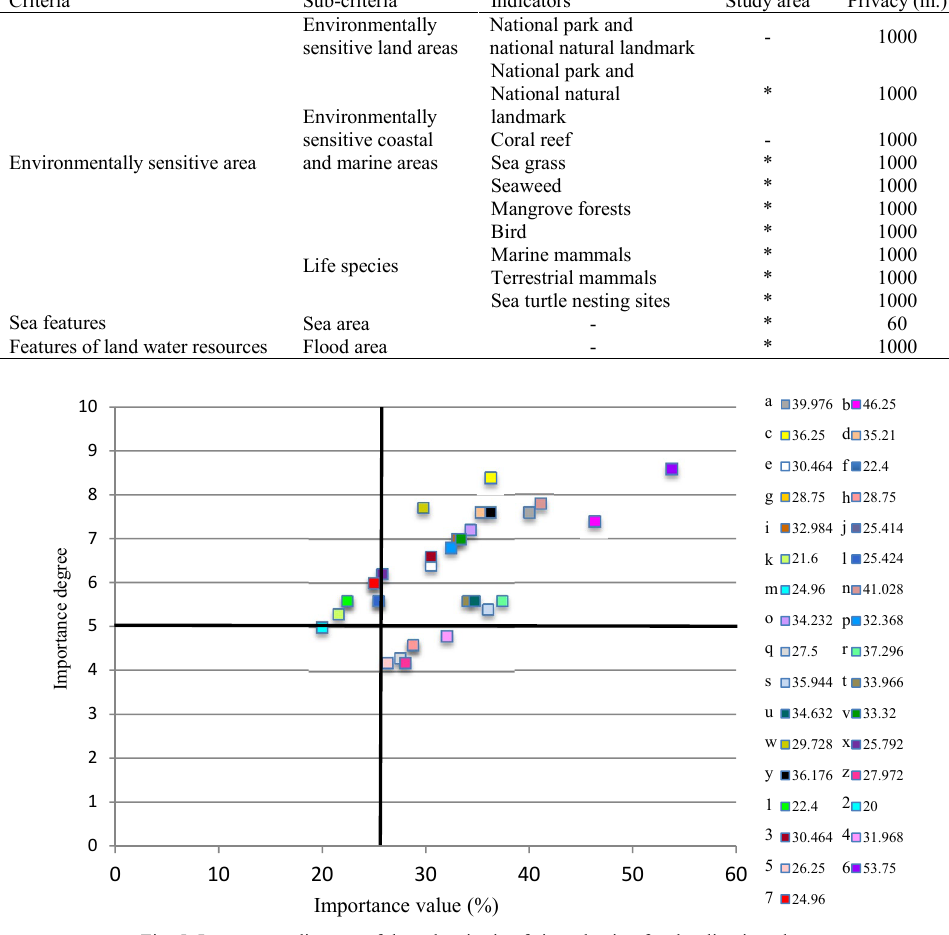
Fig. 5: Importance diagram of the sub-criteria of site selection for desalination plants